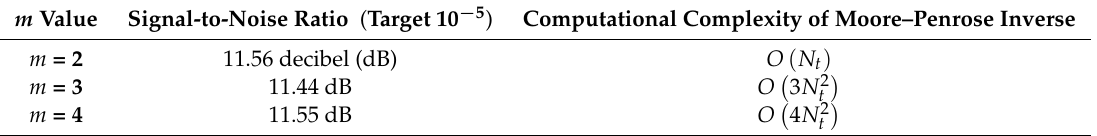
Figure 2. Bit error rate (BER) curves of the proposed signal detection algorithm with different value m , where K = 3. Table 1. Performance comparison for different m